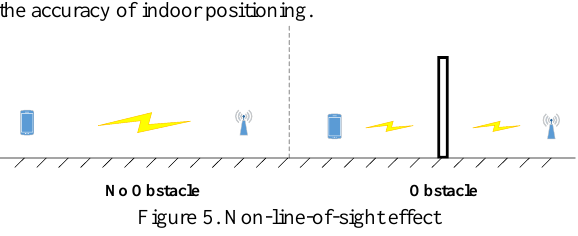
Figure 5. Non-line-of-sight effect